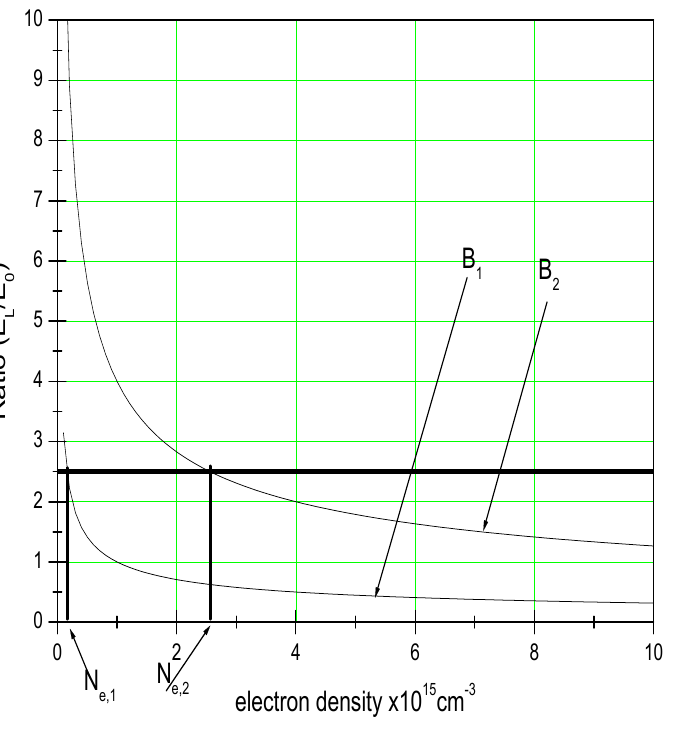
Figure 1. The ratio of the Lorentz to the Stark field for two different magnetic